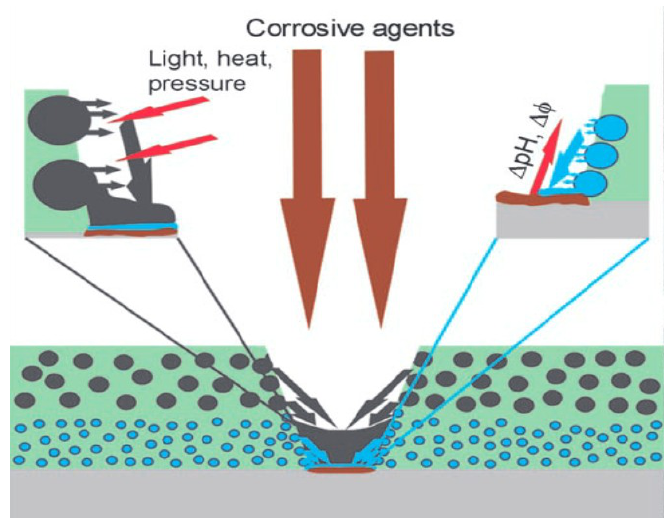
Figure 6. Nanomaterial self-repairing mechanism for surface coatings [50].